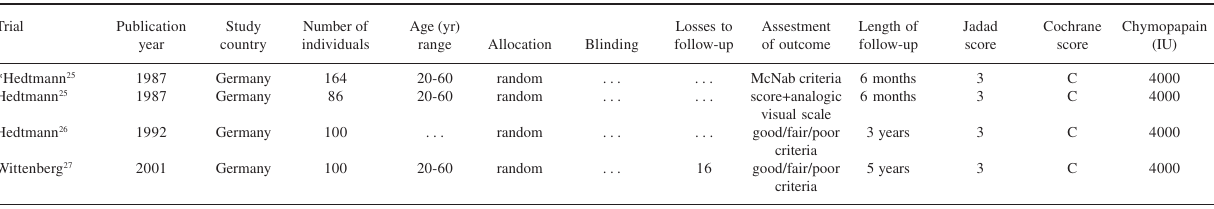
Table 2 - Clinical trials of chemonucleolysis versus collagenase